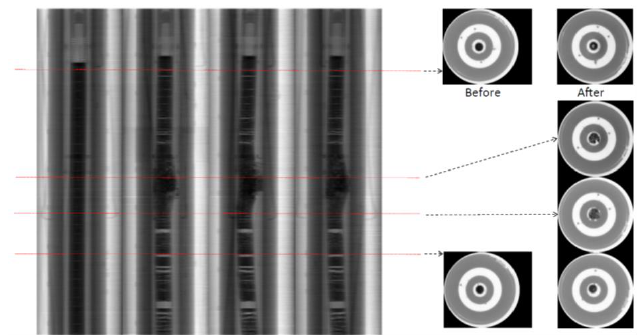
Fig. 11. Final state of the upper part of the fuel rod obtained with the X-ray measurements of IRIS equipment. The rod is clearly not centered towards the vertical axis on the tomographies: a S-shaped deformation of the rod is observed. After the test, a residual elongation of the fissile column of at least 8mm is observed. Radiographies show a clear crushing of the spring, which length is reduced of ~8mm after the test. The top end of the upper plug did not move axially. The spacer rings are identified at the same location before and after the test.